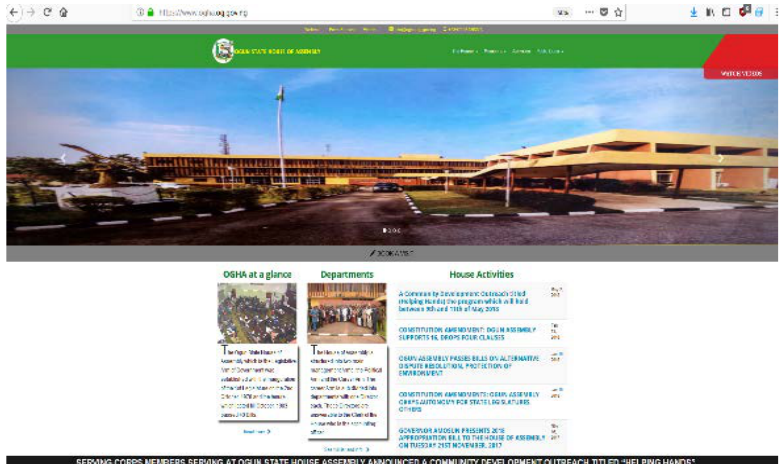
Figure 5: Ogun State House of Assembly Official Website (www.ogha.og.gov.ng)